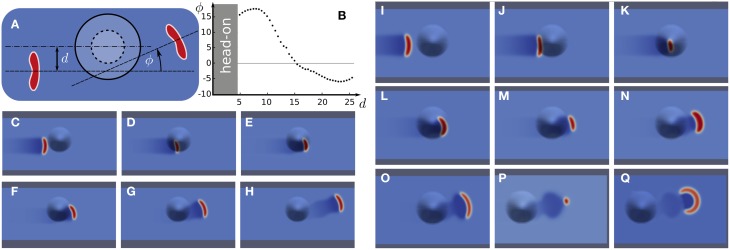
Wave segments deflected by a bump. (A) Scheme with definitions of offset parameter d and deflection angle ϕ. (B) Deflection angle ϕ vs. offset d. (C–H) Numerical simulation of a positive deflection. (I–Q) Numerical simulation of head-on collision with wave destruction.